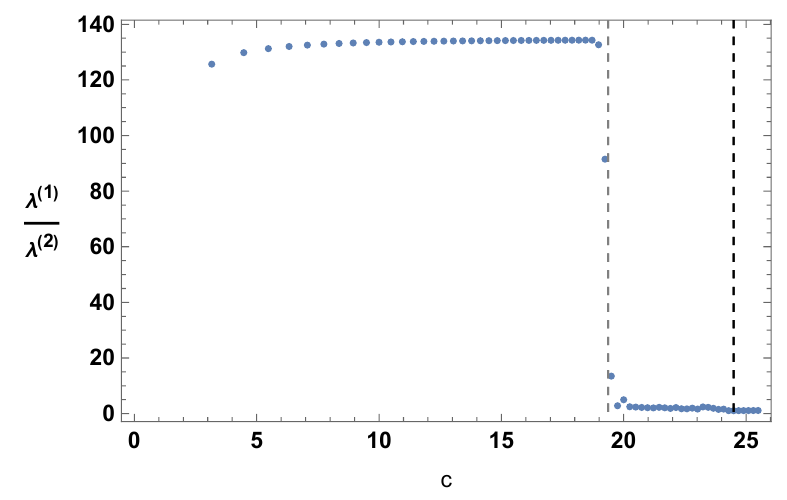
Figure 7 . The ratio of the largest to second largest ( λ (1) /λ (2) ) singular values of the off-diagonal block for the square cut at N = 600 . Before the cut begins crossing the disk boundary there is a clear single singular value that dominates, after the crossing there is a sharp transition to a regime where multiple singular values are